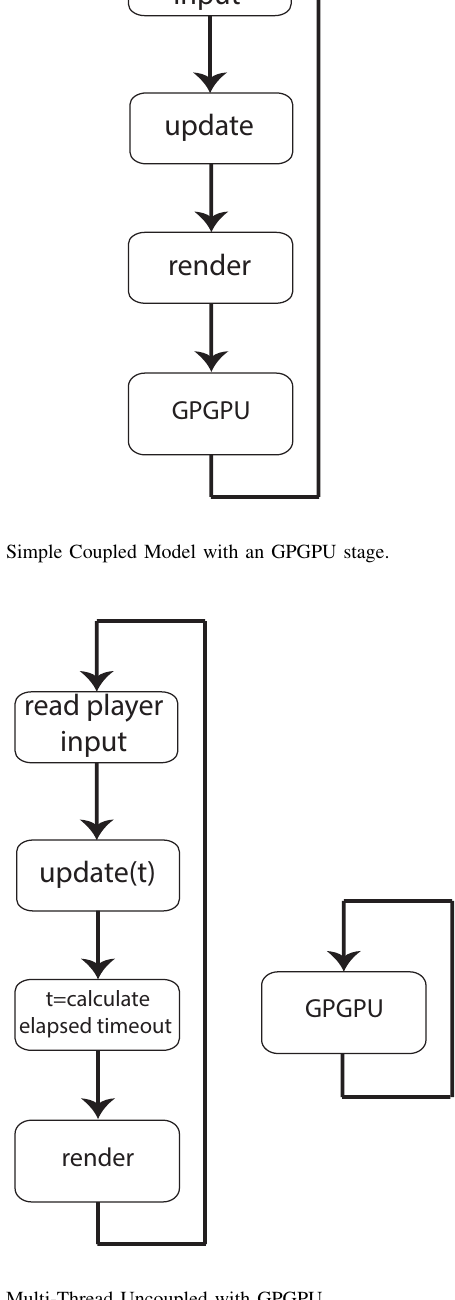
Figure 8. Multi-Thread Uncoupled with GPGPU.